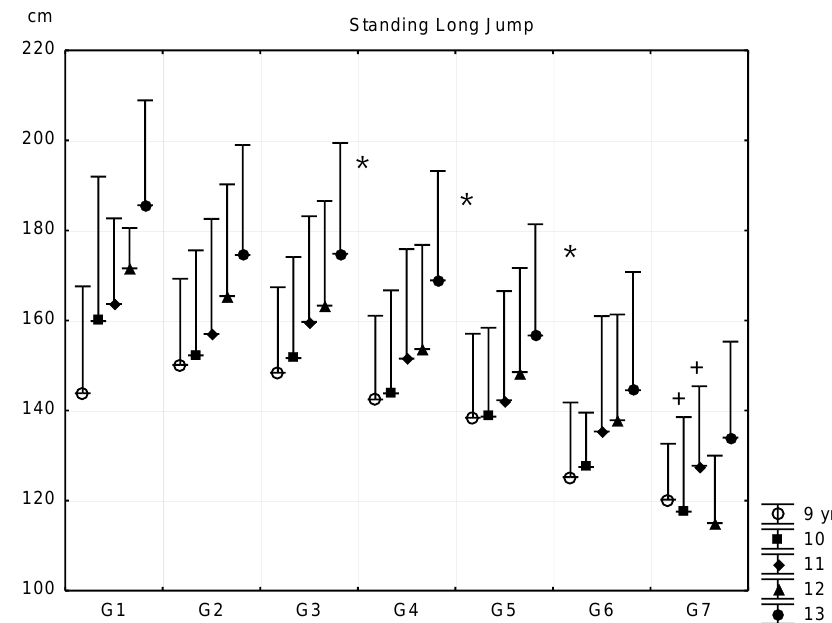
Figure 6. Relationship between body fat percentage and standing long jump (mean + SD). 1—F% < 8.00; 2—F% = 8–11.99; 3—F% = 12.00–15.99; 4—F% = 16.00–19.99; 5—F% = 20.00–23.99; 6—F% = 24.00–27.99; 7—F% > 28; F% body fat percentage; * significant difference among subsequent groups; + significant difference in certain consecutive groups, p < 0.05.